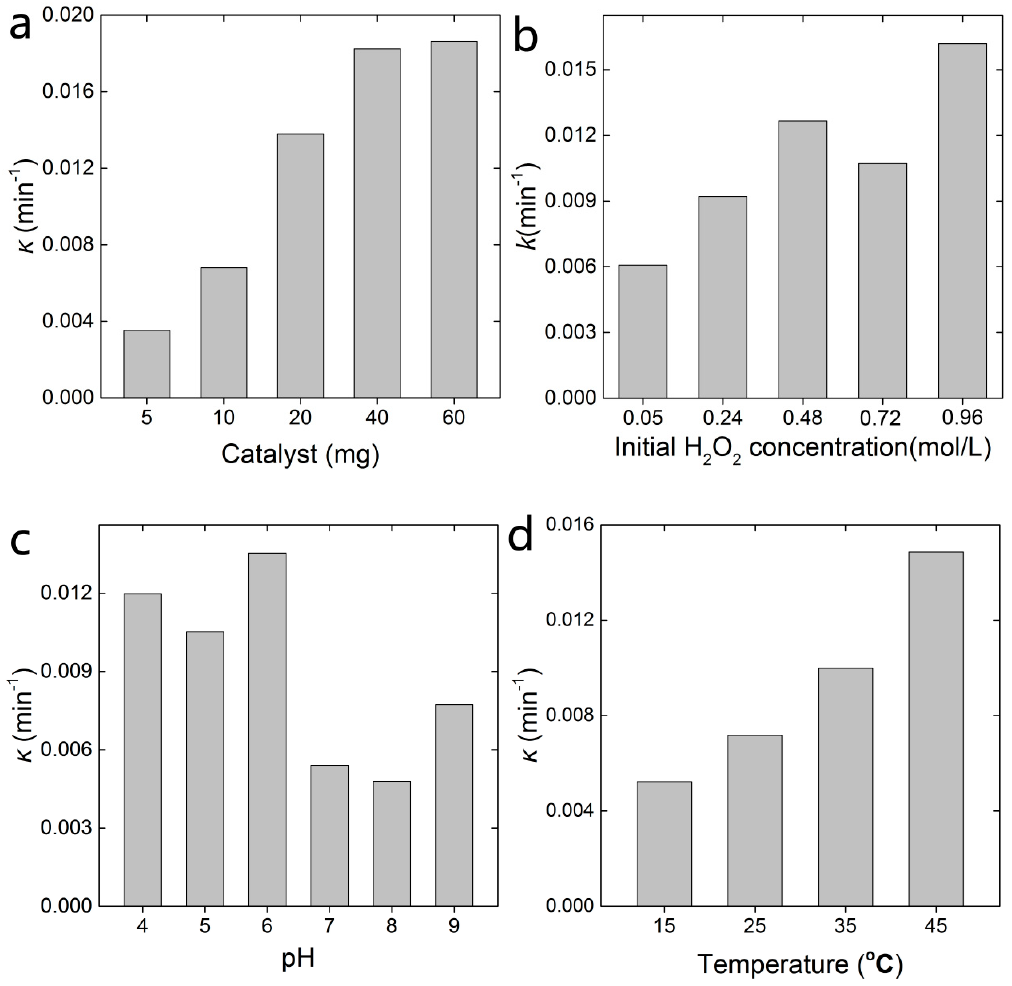
Figure 6. Influencing factors on the decoloration performance of the FTCNC-H 2 O 2 Fenton-like system. ( a ) Catalyst amount; ( b ) H 2 O 2 volume; ( c ) pH; ( d ) temperature.